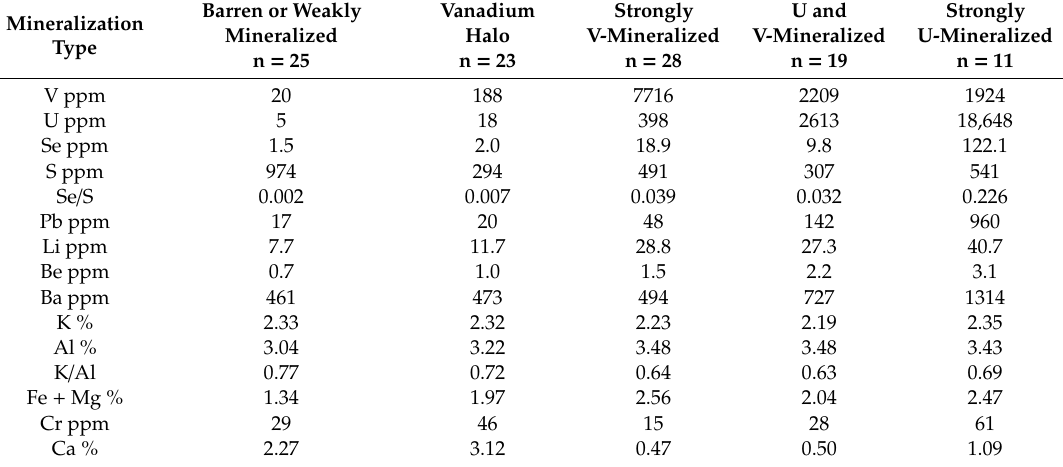
Table 1. Geometric mean * abundances of key elements and ratios by mineralization